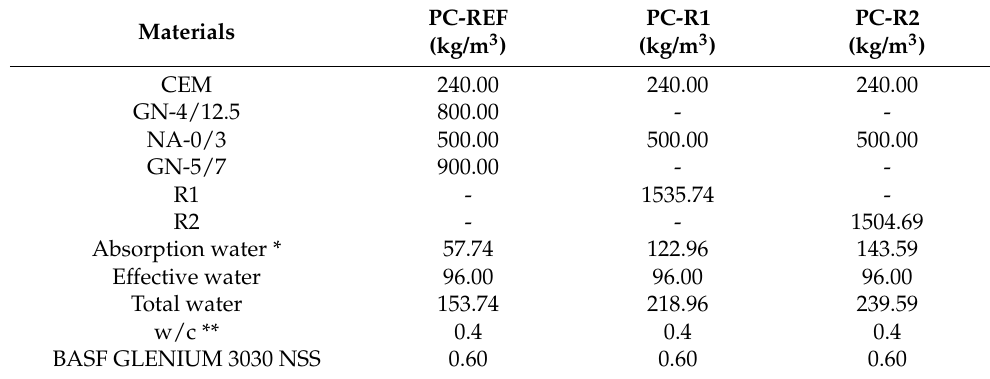
Table 2. Dosage of vibro-compacted concrete samples (per cubic